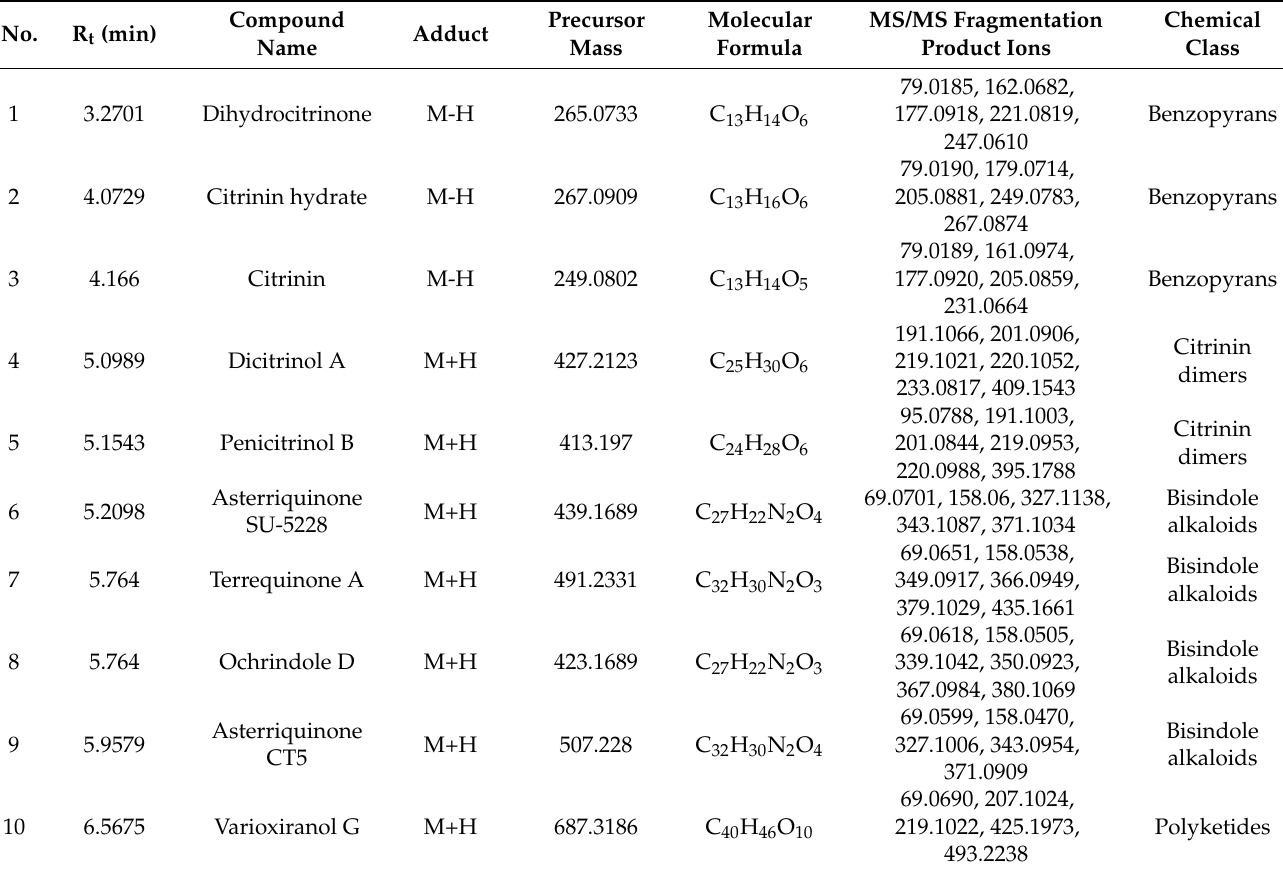
Table 1. Putatively identified unique metabolites of A. niveus Fv-er401 ethyl acetate extract in positive and negative